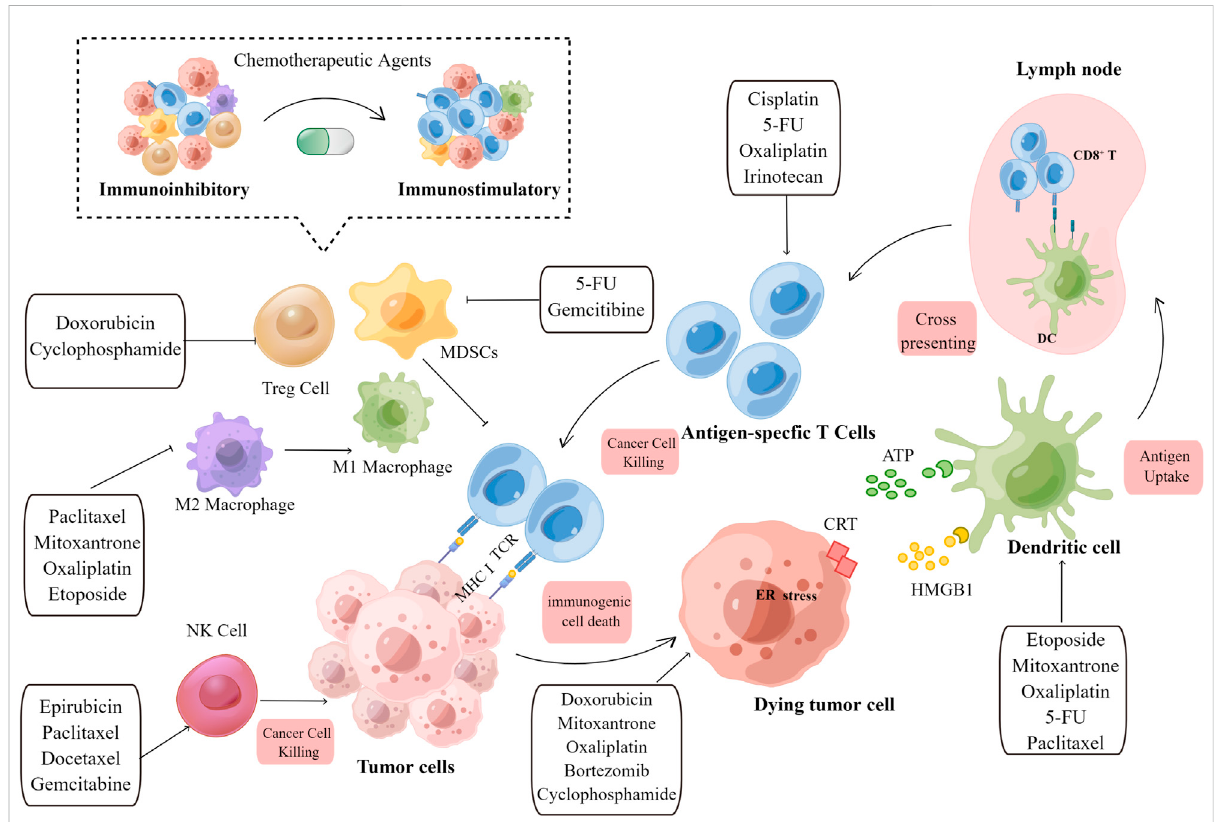
FIGURE 1 Overview of the immunostimulatory properties of chemotherapeutic agents. Immunogenic effects: When tumor cells are exposed to chemotherapeutic agents, TAA, TSA, and DAMPs released by dying tumor cells are engulfed by immature DCs, which promote APC maturation. Archived antigen-bearing APCs then migrate to the tumor-draining lymph node, where they cross-prime to T cells. Subsequently, antigen-speci fi c T cells undergo clonal expansion. Activated T cells then recognize tumor cells and mediate the cytotoxic killing of tumor cells. Immuno- adjuvant effects: Chemotherapeutic agents can activate immune effector cells, including natural killer (NK) cells and dendritic cells (DCs), and promote the in fi ltration of cytotoxic T cells. The immunoinhibitory microenvironment is then transformed into an immunostimulatory microenvironment upon the depletion of immunosuppressive cells, including Treg cells, M2 macrophages, and MDSCs. Chemotherapeutic agents and their corresponding immunomodulatory effects are shown in the text boxes with arrows. TAA, tumor-associated antigen; TSA, tumor speci fi c antigen; DAMP, damage-associated molecular pattern; DC, dendritic cell; APC, antigen-presenting cell; NK, natural killer cell; MDSC, myeloid- derived suppressor cells; Treg, regulatory T cell; MHC, major histocompatibility complex; TCR, T cell receptor; CRT,calreticulin; HMGB1, high- mobility group box